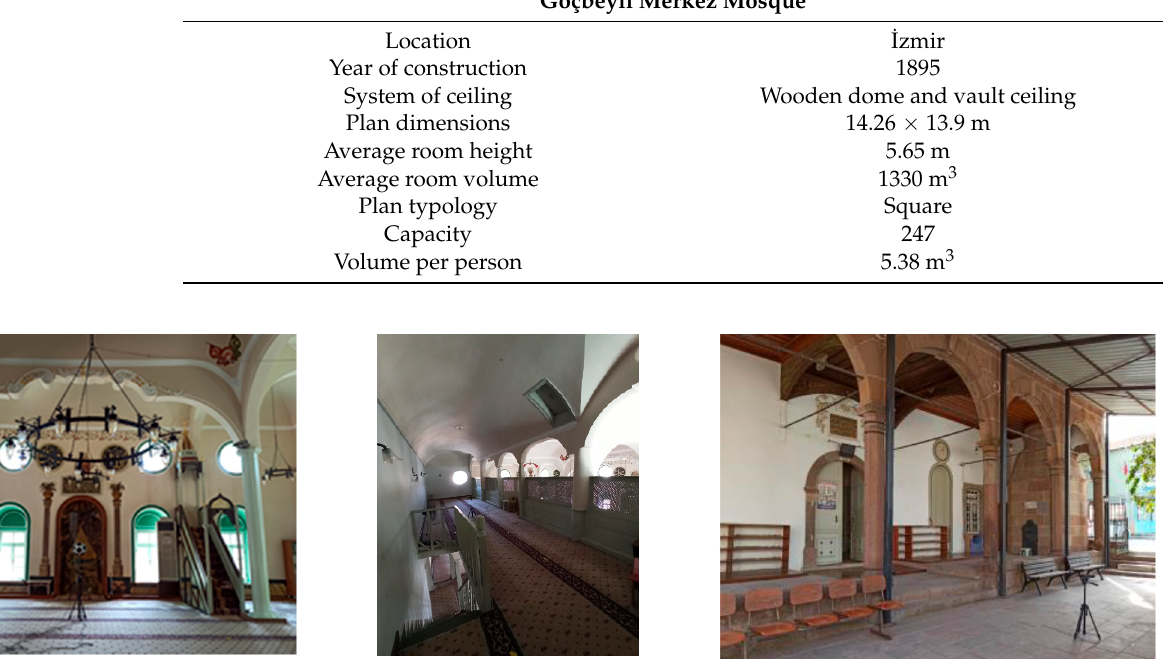
Table 8. The architectural features of Göçbeyli Merkez Mosque.